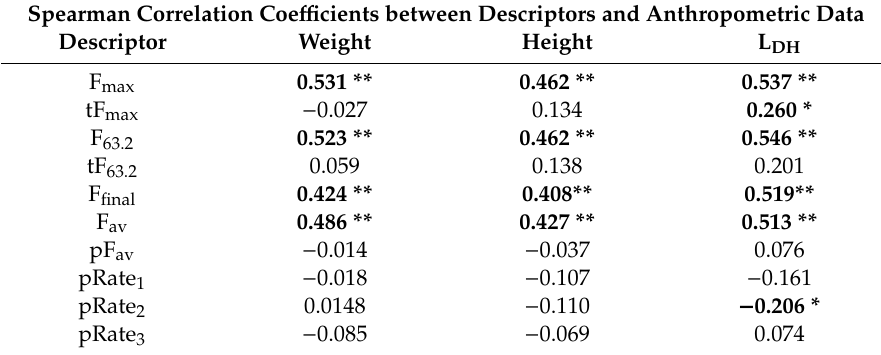
Table 3. Two tailed correlation coe ffi